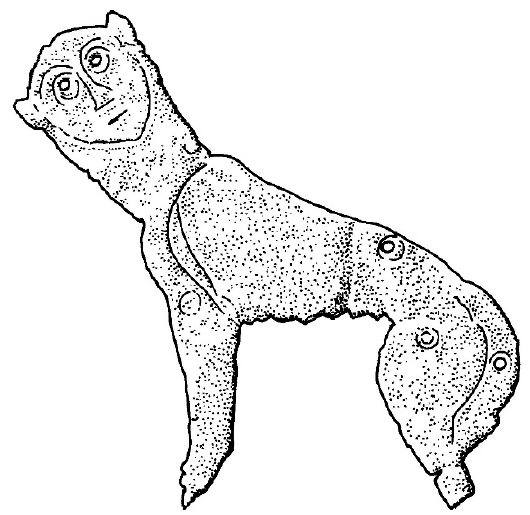
Figure 9. Bronze figurine of a human-faced dog, from the late Roman temple at Lydney, Glouces- tershire, UK.